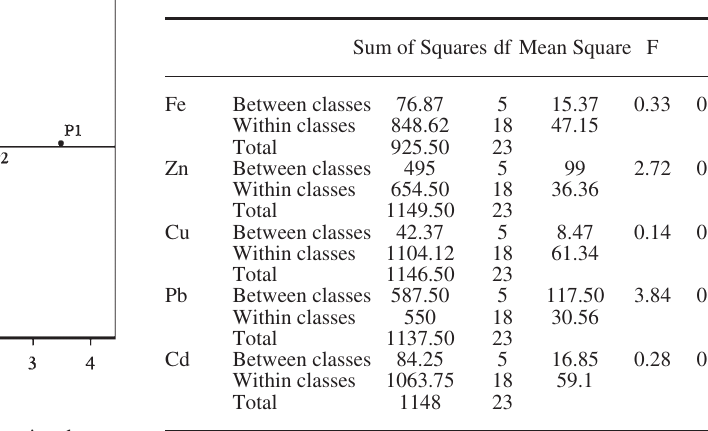
Table 9. – Kruskal Wallis test between metal concentrations in each wet-weight class; Grouping Variable: